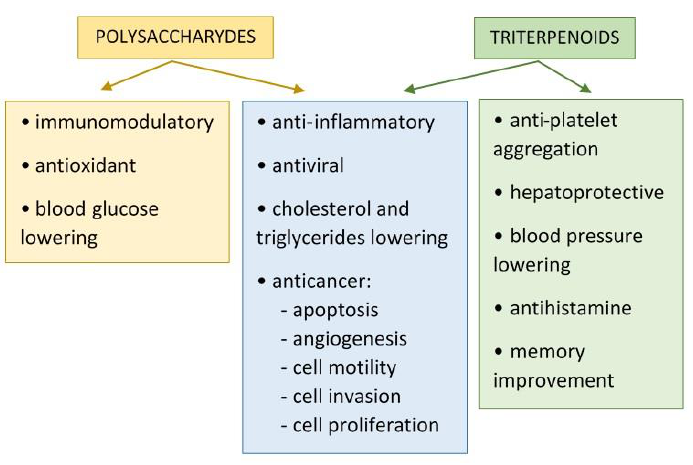
Figure 2. Structure of β-1,3-glucan with β-1,6-branching. Polysaccharide chains can form triple helices that are stabilized by hydrogen bonds.